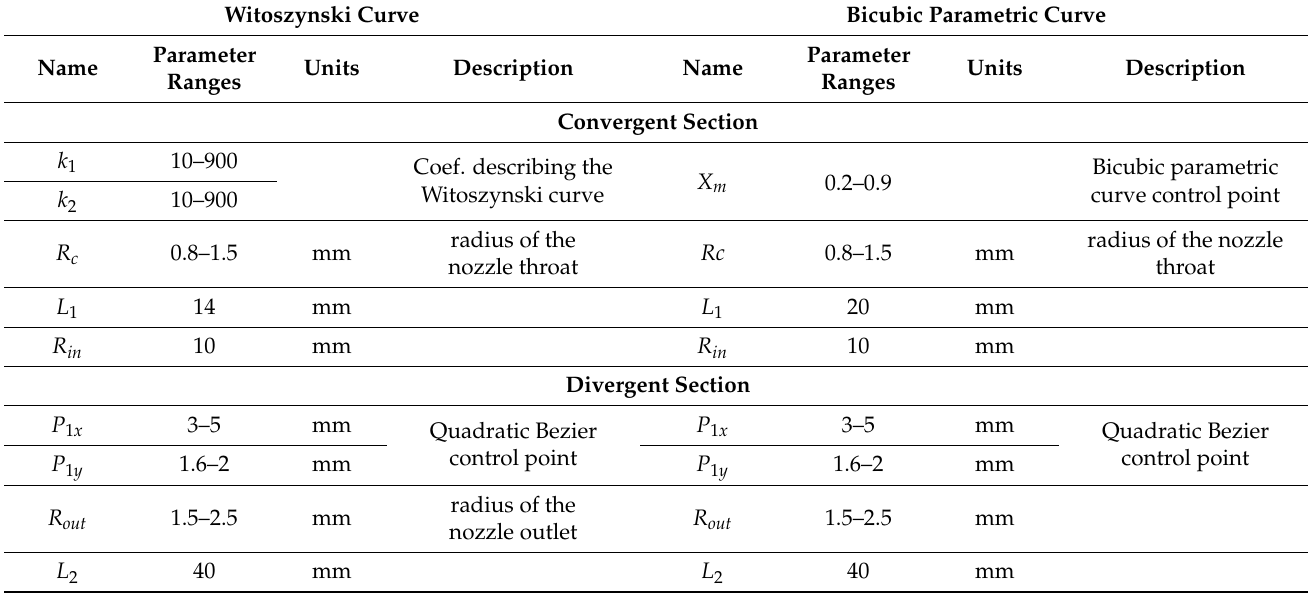
Table 2. Parameters used for numerical calculations.